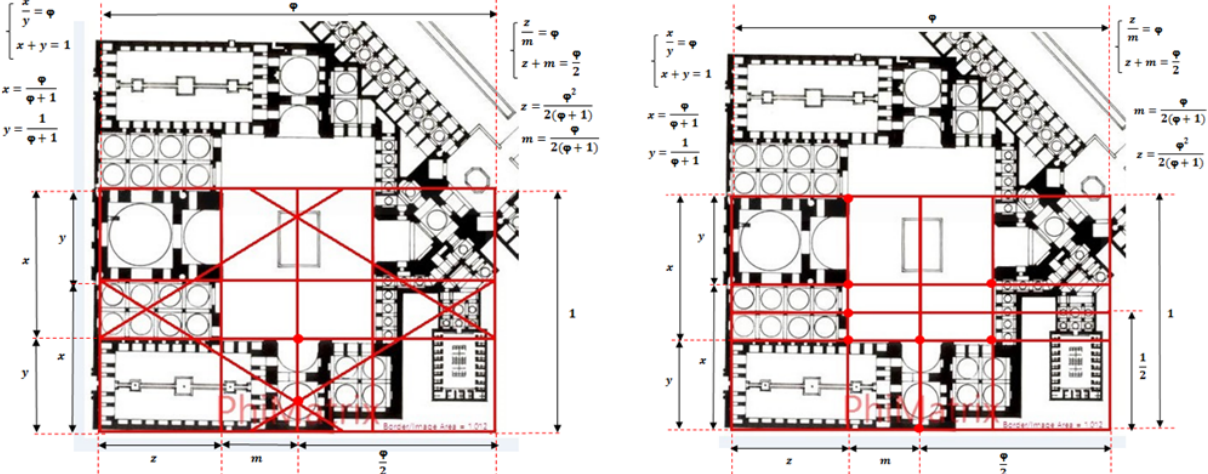
Figure 4: Adaptation of horizontal and vertical divisions of the southern plane with Golden distances